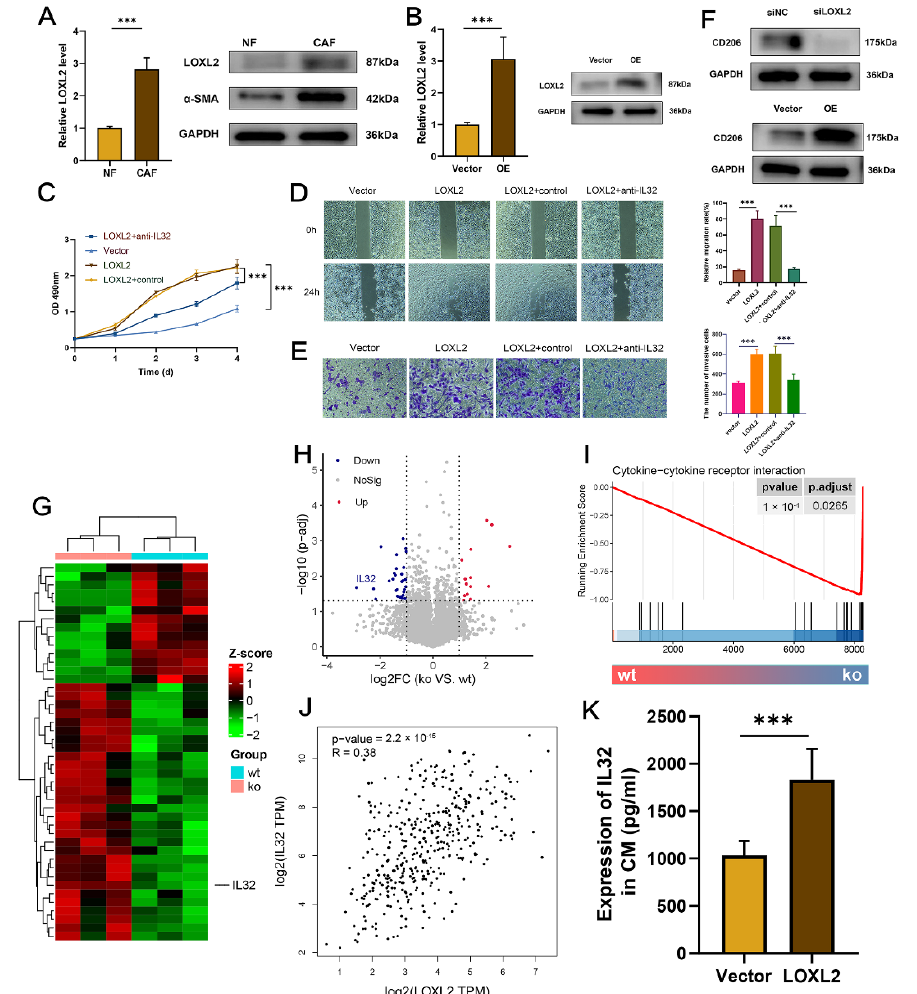
Figure 6. Upregulated LOXL2 in CAFs promoted the proliferation, migration, and metastasis of BCa cells: ( A ) LOXL2 and α -SMA were upregulated in CAFs at mRNA and protein levels. ( B ) qRT-PCR and WB verified the efficacy of overexpression. ( C ) CCK-8 assay demonstrated the pro-proliferation of LOXL2 in CAFs together with or without anti-IL32. ( D , E ) T24 cells were treated the same as in ( C ), and the wound-healing assay ( D ) and Transwell assay ( E ) were carried out to evaluate the migrative and invasive potentials of tumor cells. ( F ) CD206 protein level was affected by conditioned LOXL2. ( G , H ) IL32 was downregulated in the siLOXL2 group. Heatmap demonstrated the top DEGs of each group. The threshold for volcano plot was |log2FC| >1 and adj. p .Val. < 0.05. ( I ) Enriched term in siLOXL2 group. ( J ) Correlation between LOXL2 and IL32 (GEPIA, http://gepia.cancer-pku.cn/index.html, accessed on 9 December 2022). ( K ) ELISA demonstrated the IL32 protein expressions in the culture supernatant of CAFs with conditioned LOXL2. *** p <